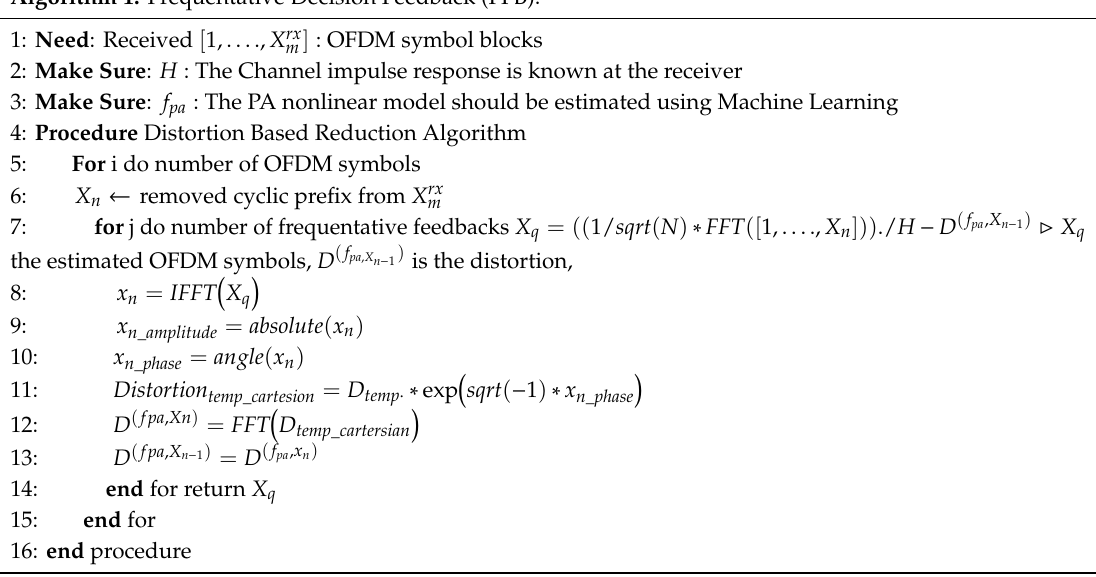
Algorithm 1. Frequentative Decision Feedback (FFB).